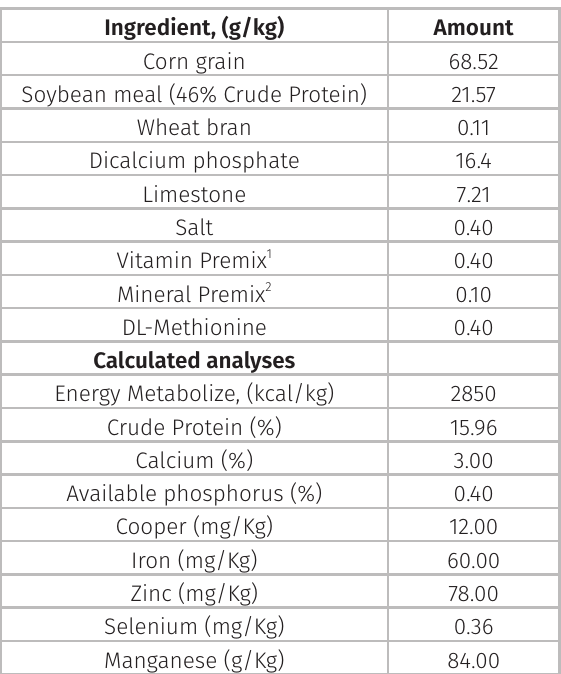
Table II. Ingredient composition and calculated nutrient analysis of the basal diets of broiler